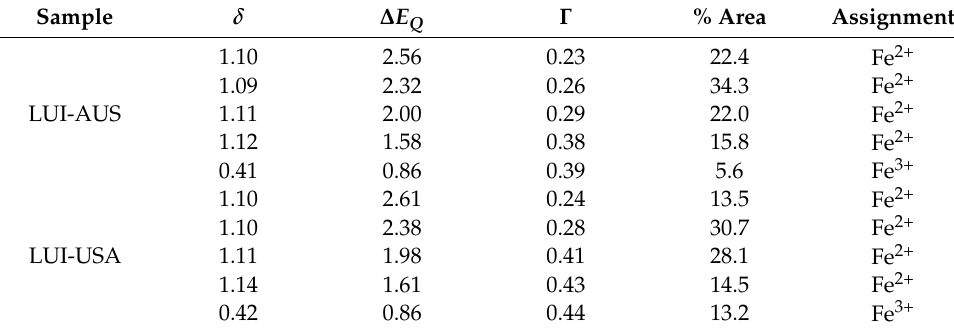
Figure 1. 57 Fe Mössbauer spectrum of the studied samples obtained at room-temperature. Fitted absorption doublets assigned to Fe 2+ and Fe 3+ are indicated in blue and red, respectively. Diamonds denote measured spectrum, and black curve represents the summed fitted spectrum. Table 1. Mössbauer parameters for luinaite-(OH).